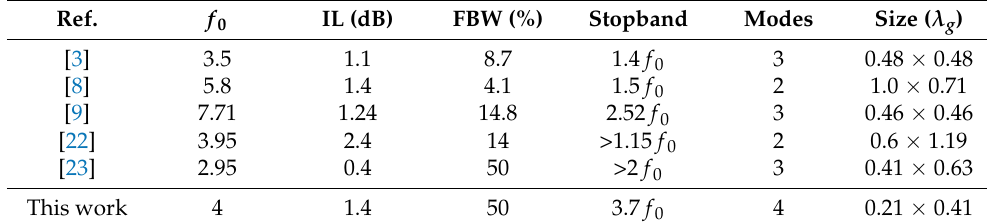
Figure 13. The fabricated filter. Table 1. Comparison with the related references.